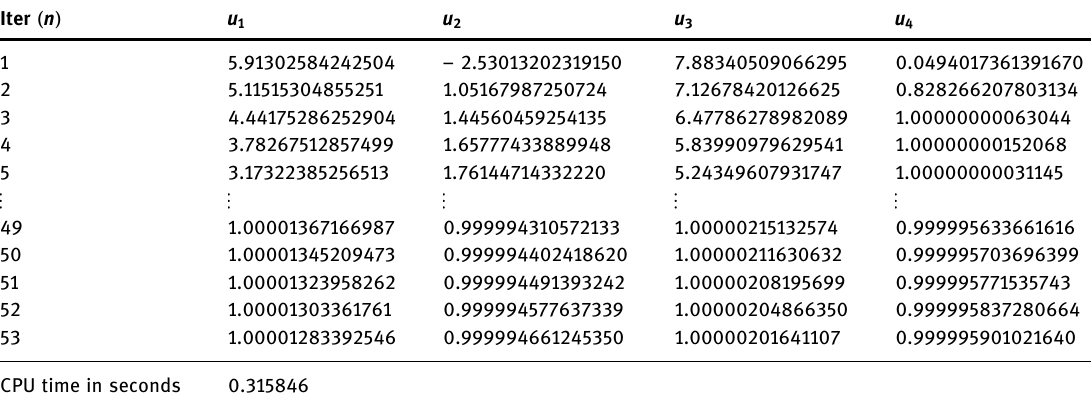
Table 10: Example 4.2: Numerical study of Algorithm 1 and